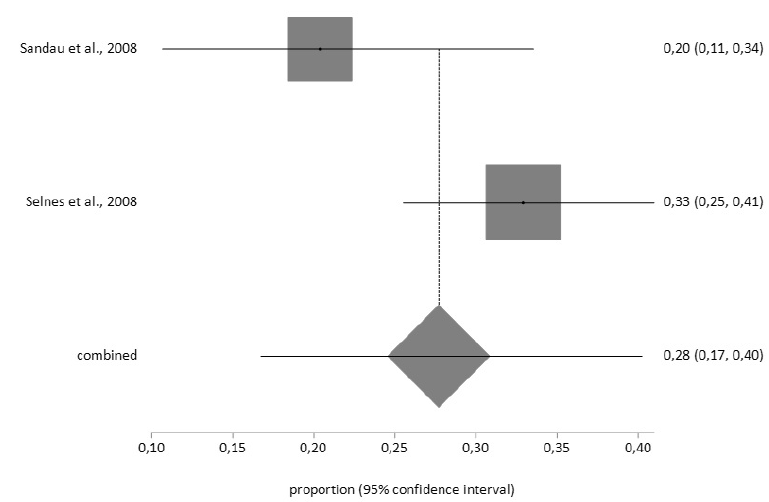
Figure 7. Forest plot for post-CABG depression using PHQ-9.